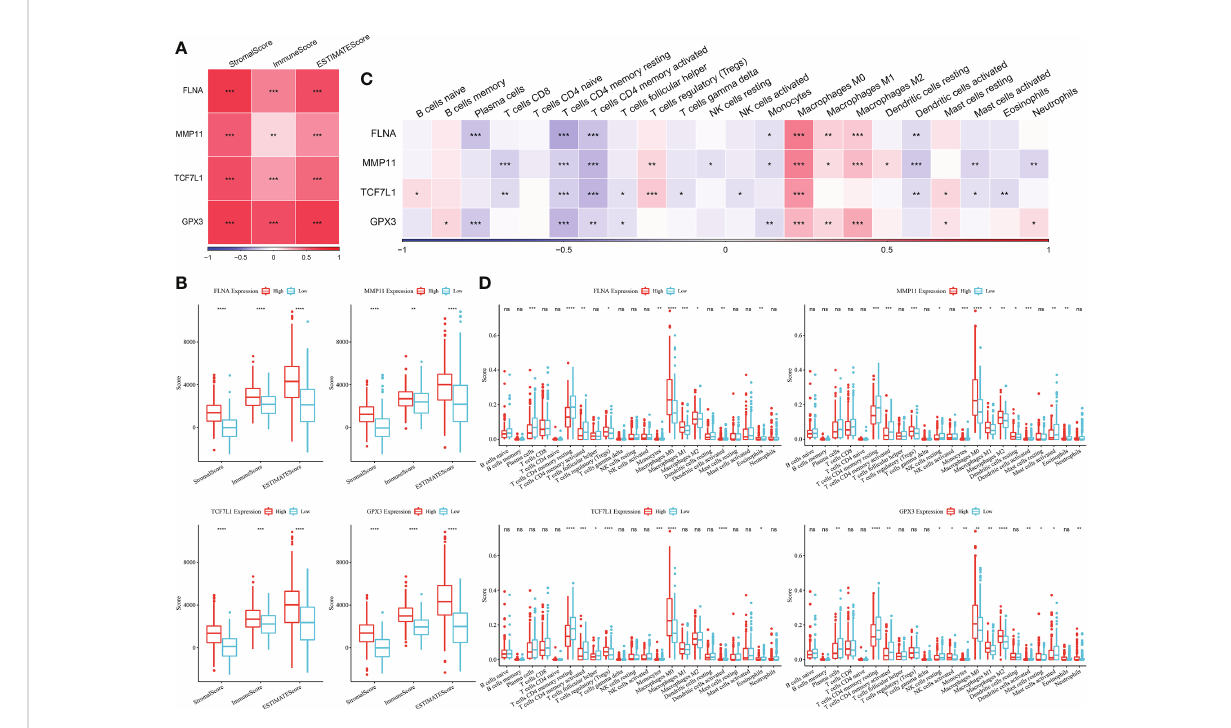
FIGURE 7 (A) Heat map of the correlation between key genes and immune scores predicted using the ESTIMATE algorithm; (B) Comparison of immune scores in the high- and low-expression groups (Wilcoxon test); (C) Heat map of the correlation between key genes and immune cell scores predicted using the CIBERSORT algorithm; (D) Comparison of the scores of 22 immune cells between the high- and low-expression groups (Wilcoxon test; *P < 0.05; **P < 0.01; ***P < 0.001; ****P < 0.0001). ns, no signi fi